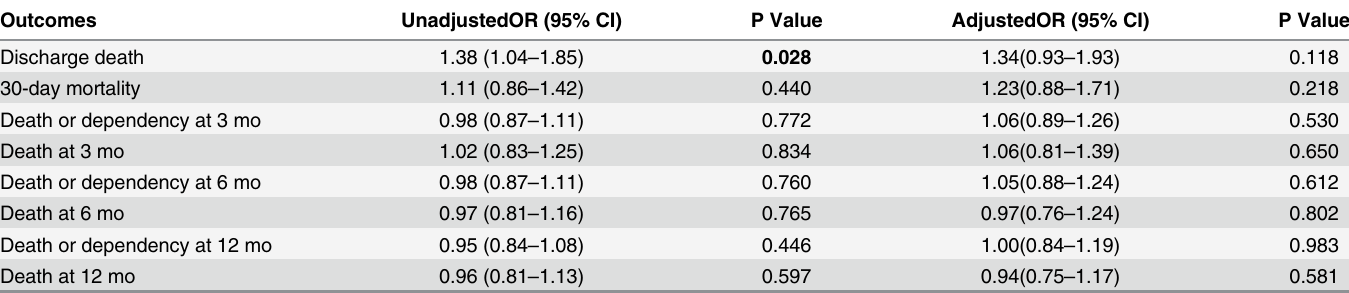
Table 4. Unadjusted and Adjusted Odds Ratios of Poor Outcomes in Ischemic Stroke Patients: Off-hour versus On-hour Presentations. Outcomes